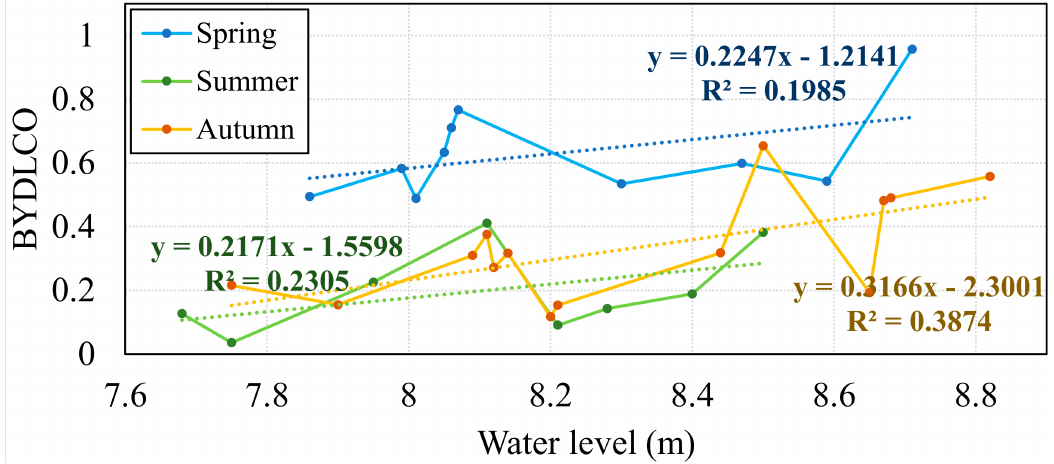
Figure 7. Change of BYDLCO with rising water level in spring, summer, and autumn